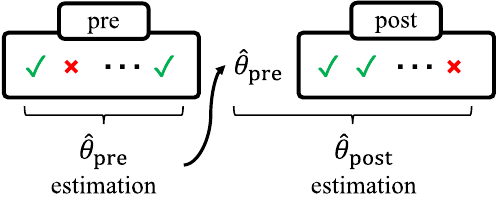
FIG. 1. Illustration of the use of collateral information for proficiency estimation on the